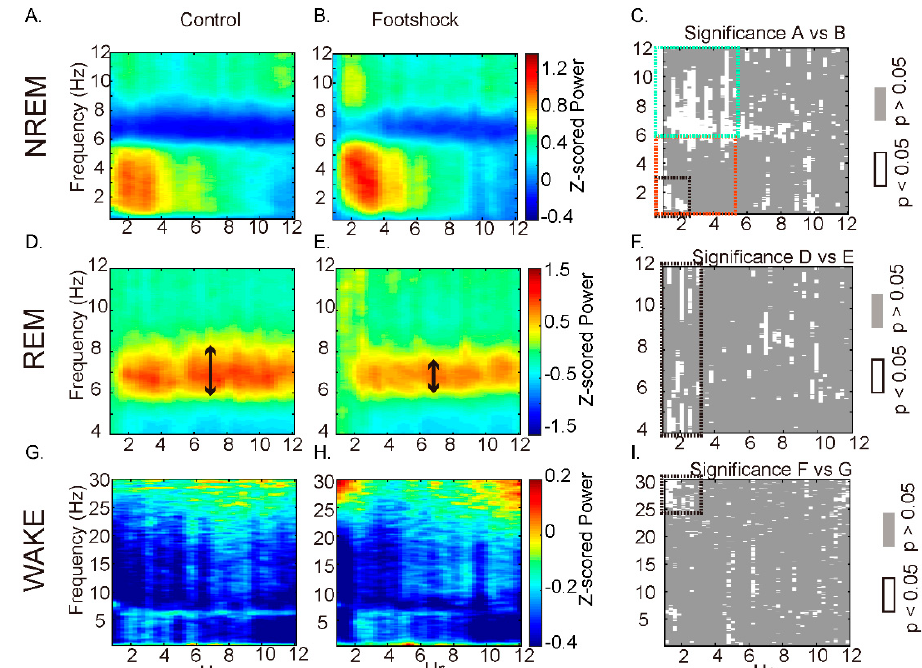
Figure 2. Alterations of spectrogram and statistical significance testing after the footshock stimuli. ( A ) Mean spectrogram of NREM sleep obtained from the control group. ( B ) Mean spectrogram of NREM sleep acquired from the footshock group. ( C ) Statistical significance testing for the difference between ( A , B ). The black-dashed-line area marks 1–3 Hz, the red-dashed-line area marks 1–6 Hz, the green-dashed-line area marks 6–12 Hz. ( D ) Mean spectrogram of REM sleep obtained from the control group. ( E ) Mean spectrogram of REM sleep observed from the footshock group. The arrows in ( D , E ) represent a wider predominant frequency band in the control than that obtained from the footshock. ( F ) Statistical significance testing for the difference between ( D , E ). The black-dashed- line area marks 4–12 Hz. ( G ) Mean spectrogram of wakefulness acquired from the control group. ( H ) Mean spectrogram of wakefulness recorded from the footshock group. ( I ) Statistical significance testing for the difference between ( G , H ). The black-dashed-line area marks 25–30 Hz. The p -value applied was p = 0.05; p < 0.05 was marked by the white color.